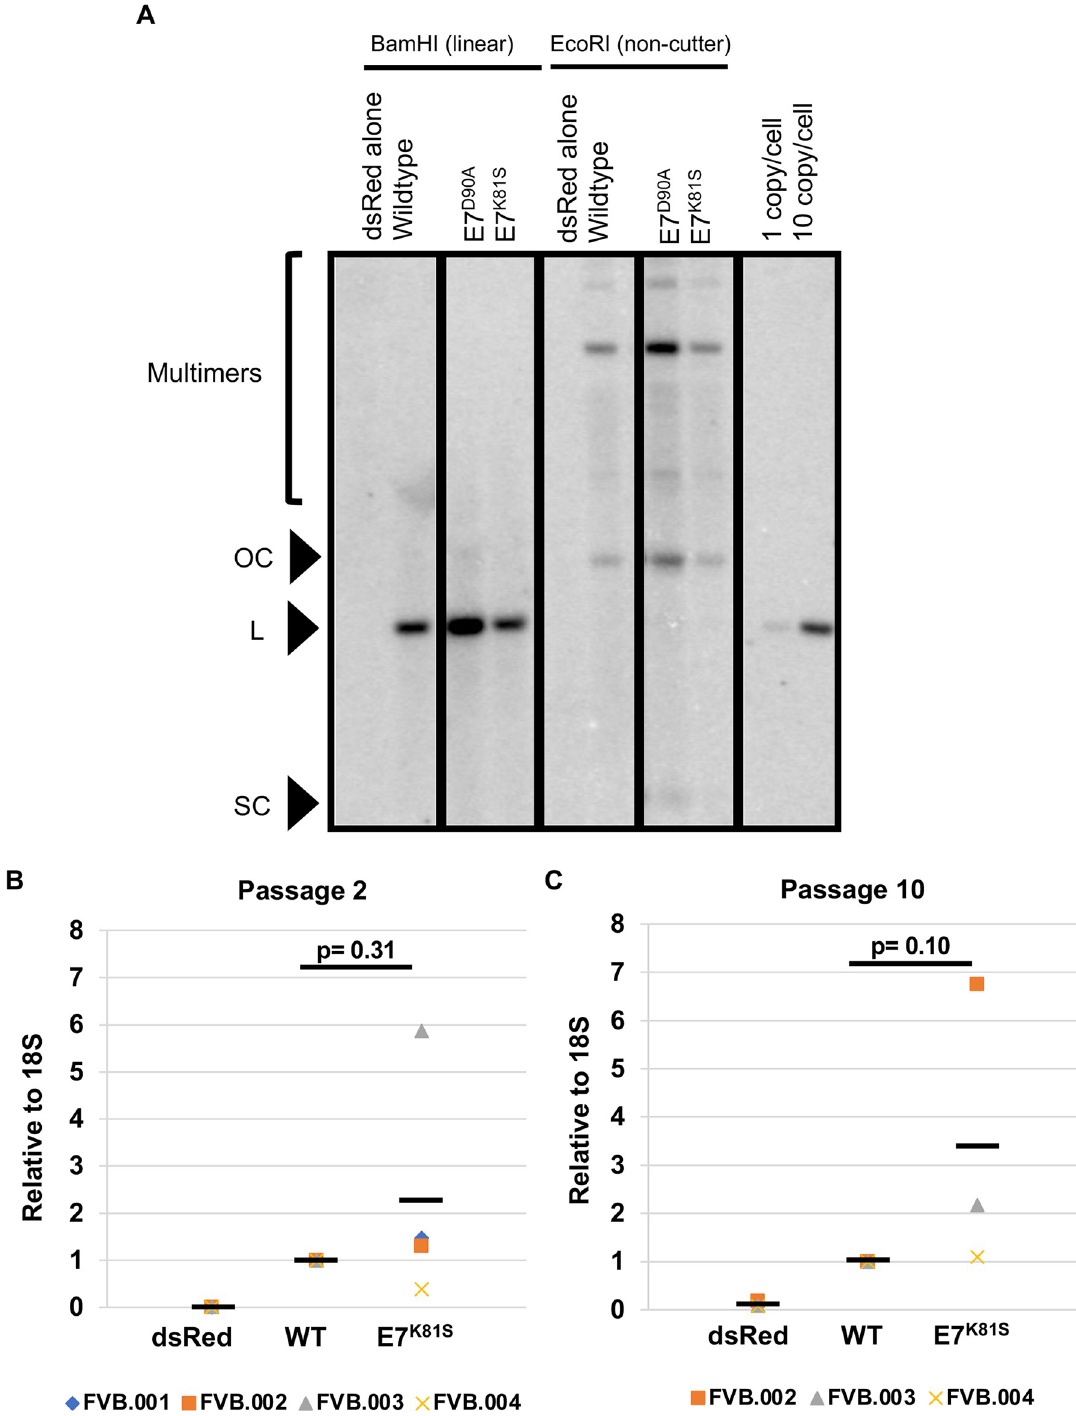
Fig 3. MmuPV1 E7 K81S mutant does not impair viral genome maintenance in basal keratinocytes. (A) Early passage mouse keratinocytes (MKs) isolated from neonates were transfected with dsRed alone or in combination with WT, E7 D90A , or E7 K81S re- circularized viral genomes. DNA was isolated and restriction digested with a linearizing enzyme (BamHI) or non-cutter (EcoRI). Southern blot analysis was performed using an MmuPV1 genome probe included a standard of 1 copy/cell and 10 copy/cell to estimate copy number level per cell. The positions of open circular (OC), linear (L), and supercoiled (SC) genomes are indicated. The different panels are derived from the same gel and have been sampled at the same exposure. An uncropped version of Fig 3A is provided in S3A Fig. (B and C) DNA isolated from transfected MKs were subjected to qPCR analysis using primers for the viral E2 gene and mouse